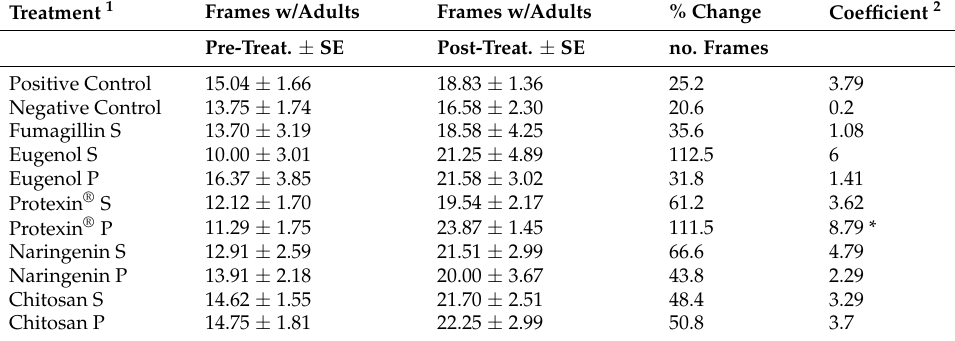
Table 3. Effect of spring 2017 treatments on number of frames covered with adult bees per colony one–two days pre-treatment and nine weeks post-treatment with the antibiotic fumagillin, prebiotics eugenol, naringenin or chitosan, or probiotic Protexin ® . Coefficients indicate how the number of frames with adult bees changed relative to the positive control. Means are from six colonies per treatment.